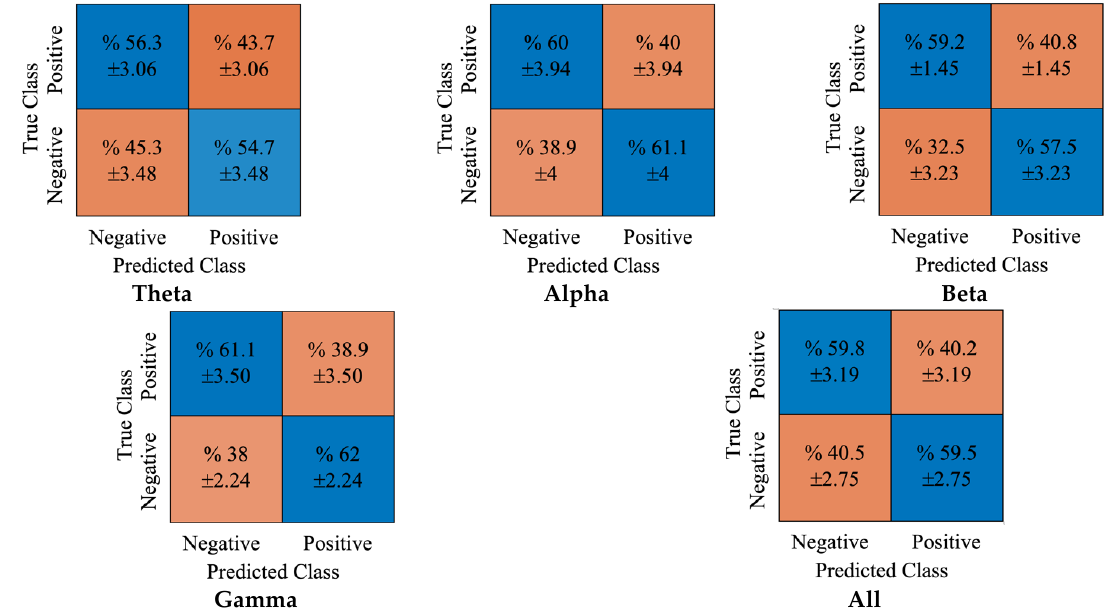
Figure 7. The obtained confusion matrices for DE features and NB classifier. Moreover, the false classifications for positive and negative classes were 39.6% and 40.8%, respectively. In Figure 8, the obtained cumulative confusion matrices for each rhythm and all rhythms using the DT classifier were provided. It can be noted that the gamma rhythm produced the best achievement using the DT classifier. While the true classification accuracies for positive and negative classes were 61.1% and 62%, respectively. The false positive and negative accuracy scores were 38.9% and 38%, respectively.